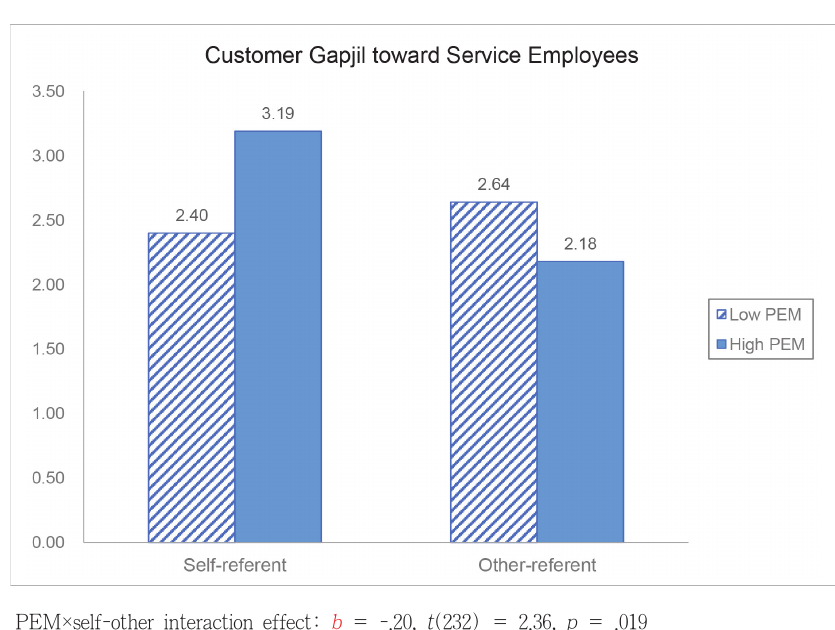
The 3-way Interaction Effect of PEM, Self-Other Referent Priming, and Temporal Focus on Gapjil (Study 2) <Figure 4-A> Present Focus (PEM is dichotomized for visual